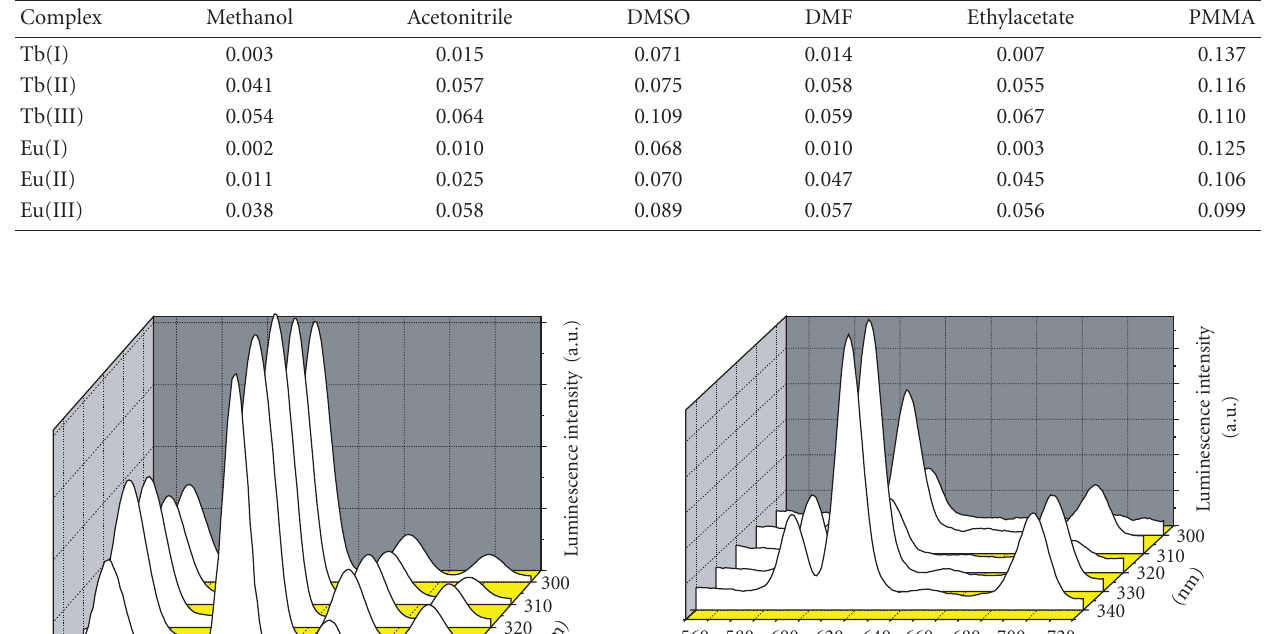
10 (cid:0) 5 M of Tb 3+ and Eu 3+ in the presence of 2 (cid:0)